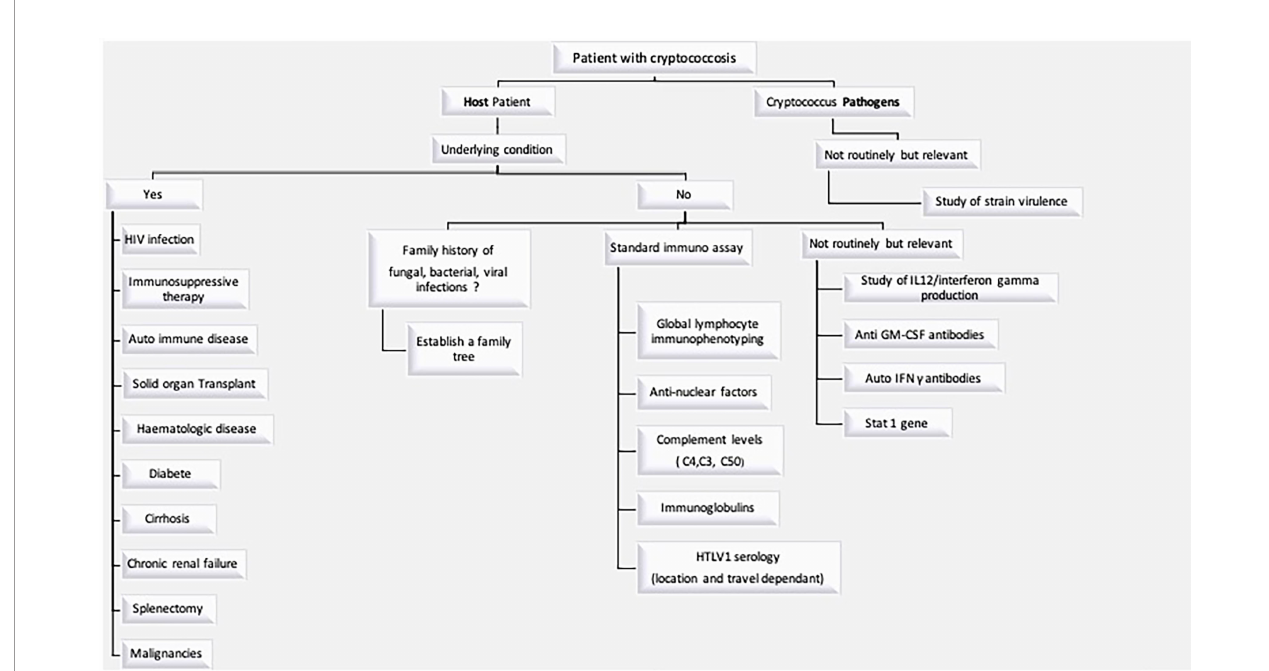
FIGURE 3 | Investigation to be performed in a patient with